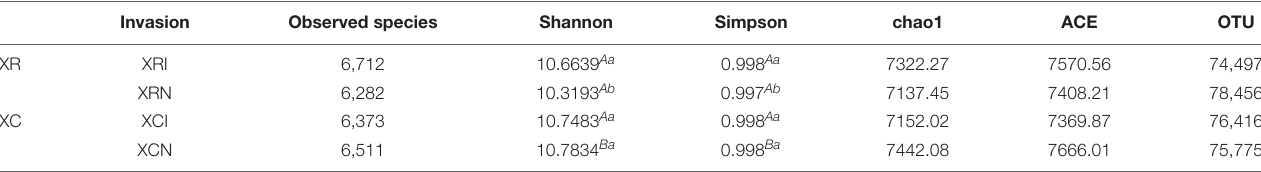
Different superscript uppercase letters indicate statistically significant differences at α = 0.05 level between river and constructed wetland. Different superscript lowercase letters indicate statistically significant differences at α = 0.05 level between invaded sites and non-invaded sites. XRI, Xinxue River invaded sites; XRN, Xinxue River non-invaded sites; XCI, Xinxue River Constructed Wetland invaded sites; XCN, Xinxue River Constructed Wetland non-invaded